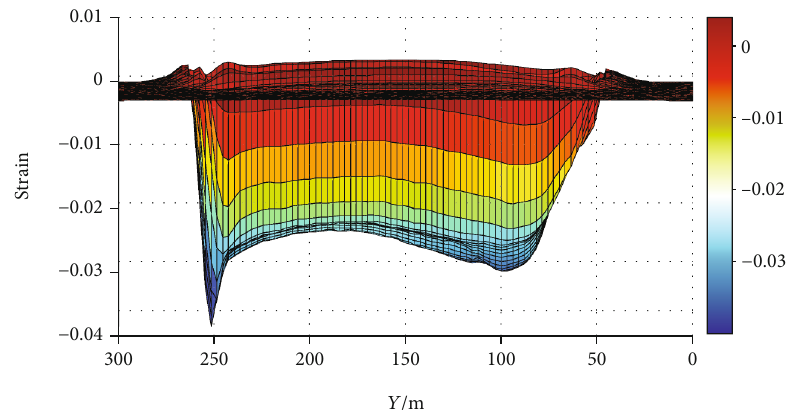
Figure 7: The main view of the volumetric